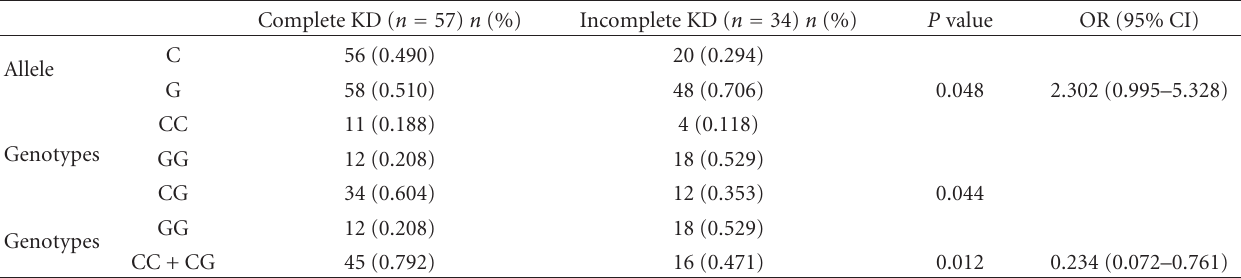
Table 6: RETN ( − 420C > G) genotype and allele frequency in the groups with complete and incomplete